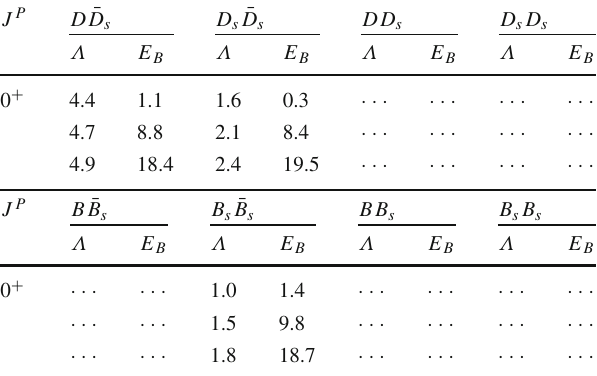
Table 2 The binding energies E B = M th − z of the bound states from the interactions D ( s ) ¯ D s / B ( s ) ¯ B s and D ( s ) ¯ D s / B ( s ) ¯ B s with some selected values of cutoff Λ . The “ · · · ” means that no bound state is found in the considered range of the cutoff. The cutoff Λ and binding energy W